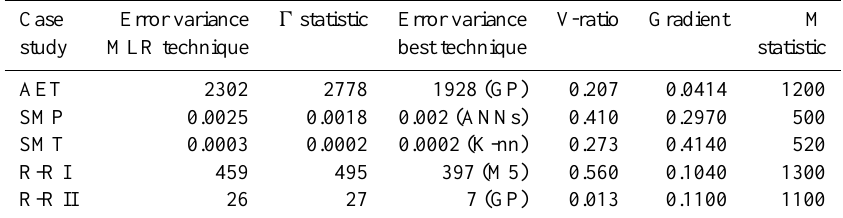
Table 18. The gamma test results on all case